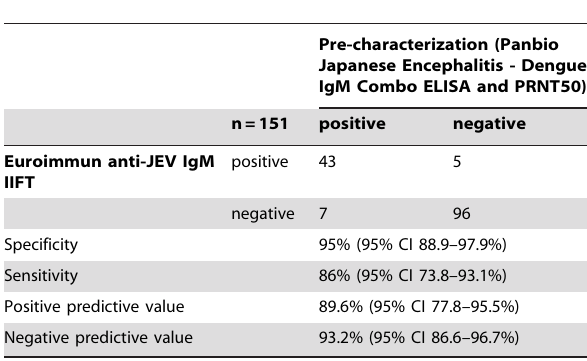
Table 2. Calculated specificity, sensitivity, positive and negative predictive values for the anti-JEV IgM IIFT in comparison to the Panbio Japanese Encephalitis - Dengue IgM Combo ELISA and PRNT50.